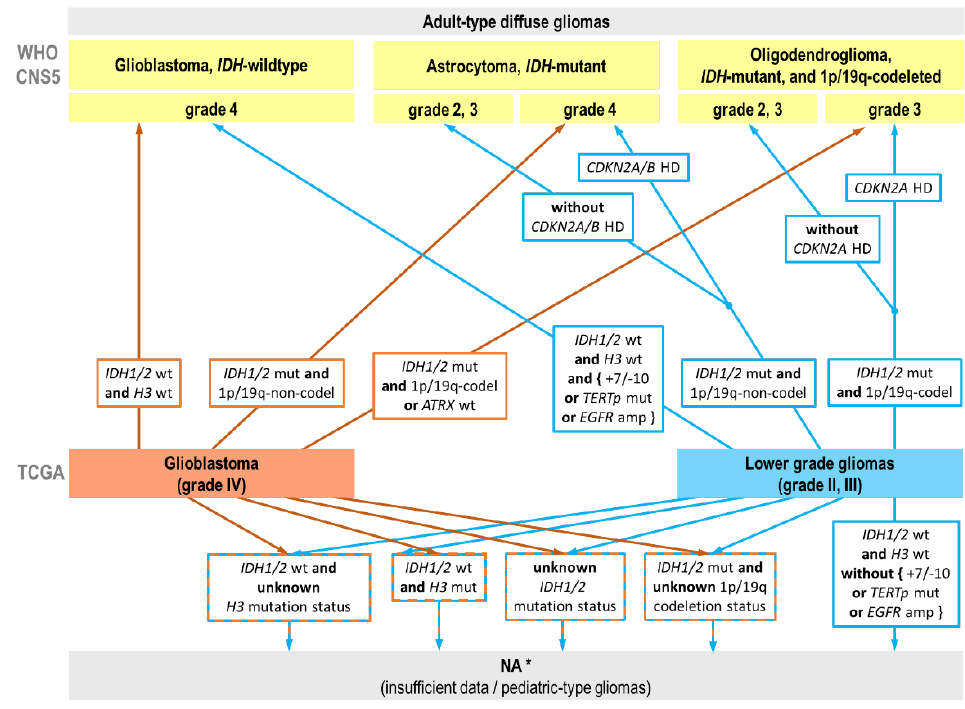
Figure 2. The algorithm of the reclassification of gliomas from The Cancer Genome Atlas (TCGA) databases based on molecular alterations according to WHO CNS5 guidelines. HD — homozygous deletion; wt — wildtype; mut — mutation; amp — amplification. * We combined “NOS” (Not Otherwise Specified) and “NEC” (Not Elsewhere Classified) into «NA» category.